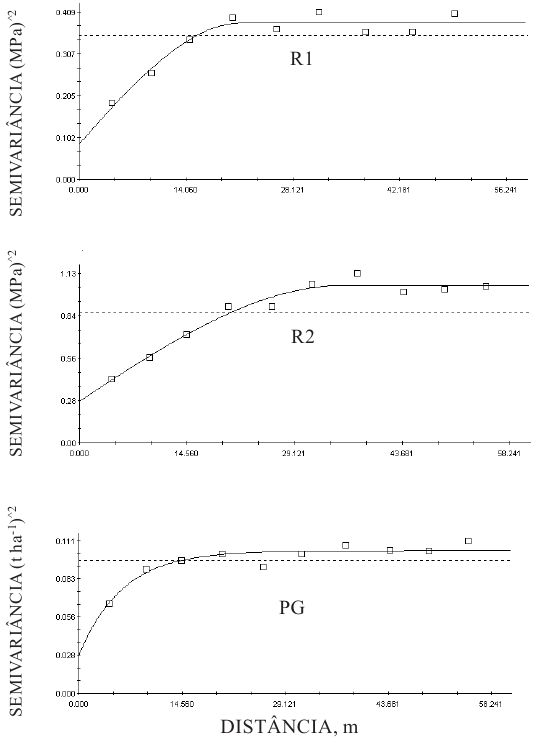
Figura 1. Semivariogramas da resistência mecânica à penetração, nas profundidades de 0–0,10 m (R1) e 0,10–0,20 m (R2) de um Latossolo Vermelho distrófico de Selvíria (MS), e do rendimento de grãos do feijoeiro